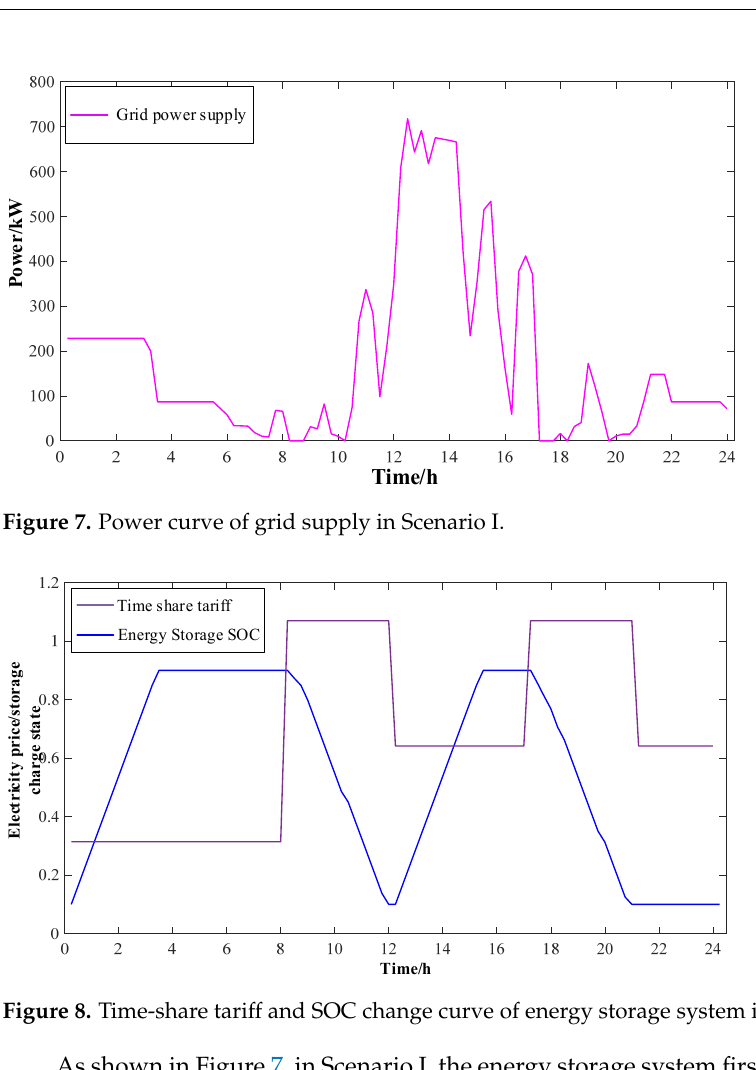
Figure 6. Load power, PV power, PV power consumption and optimal charge/discharge power curves for energy storage in Scenario I.